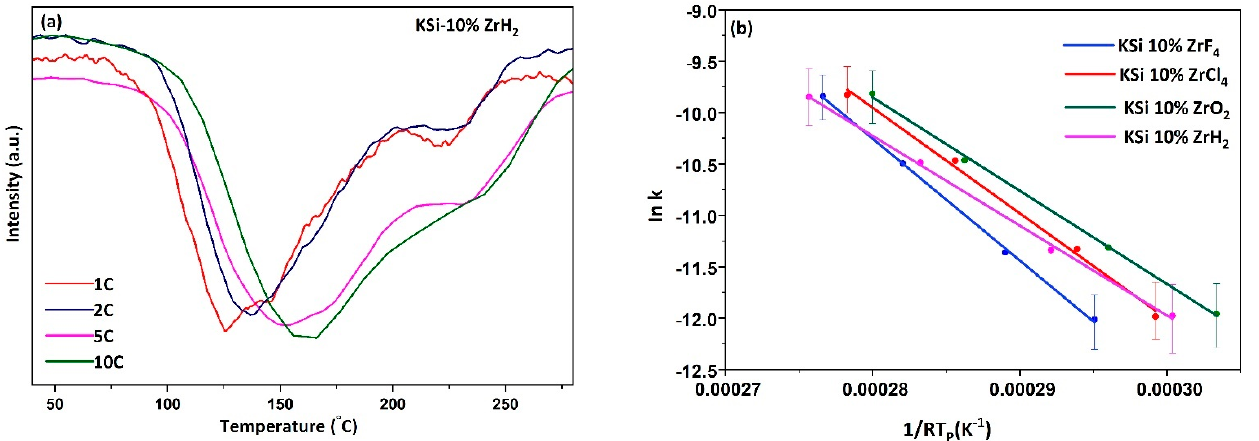
Figure 4. TG profile of catalysed KSi systems at heating rate 2 °C/min under 0.1 MPa Ar.